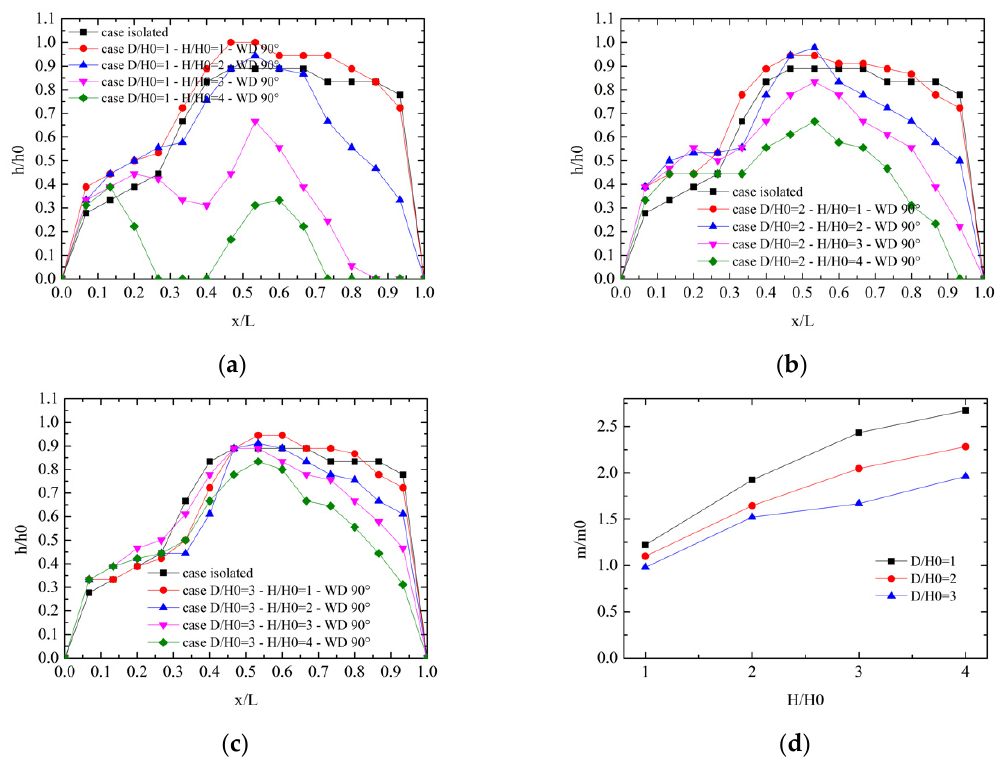
Figure 6. Normalized snow depth of the central line on the target building under the 90° wind direction: ( a ) building spacing: H 0; ( b ) building spacing: 2 H 0; ( c ) building spacing: 3 H 0; ( d ) normalized mass of particles blown off the target building.